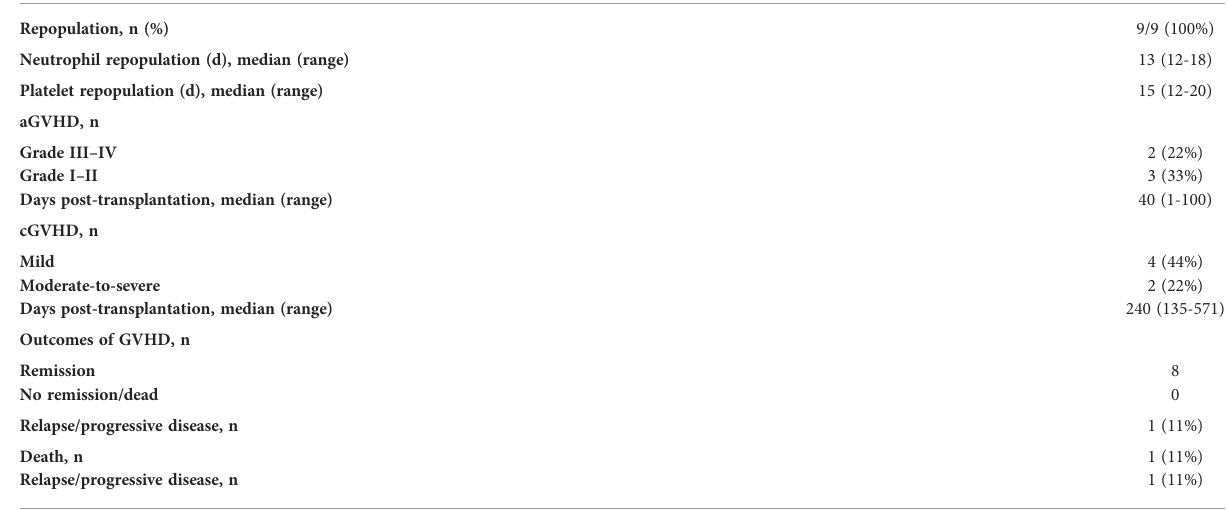
TABLE 2 Outcomes after